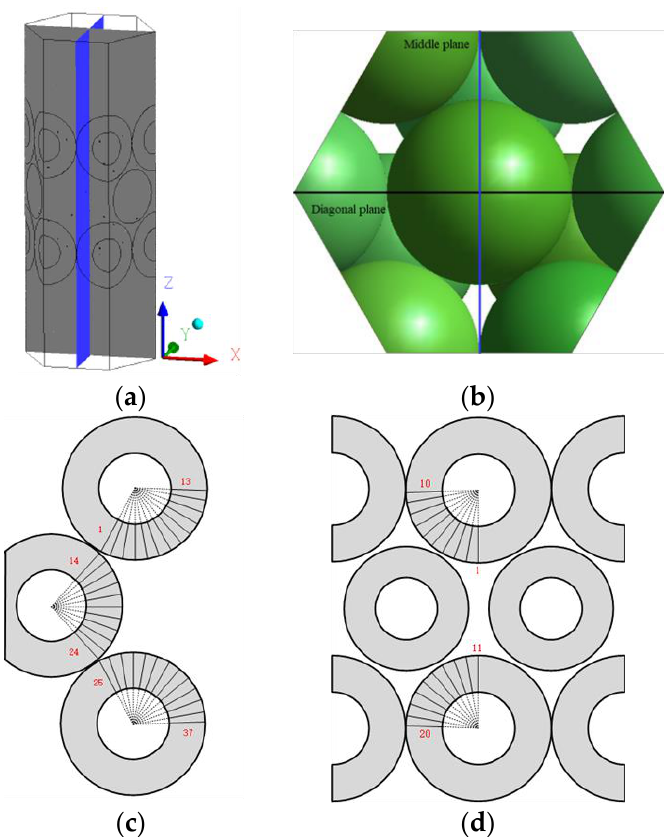
Figure 4. ( a) The middle plane (blue)and the diagonal plane (gray); ( b ) the top view of relative positions of two designated planes; ( c ) measurement locations on the middle plane; ( d ) measurement locations on the diagonal plane.